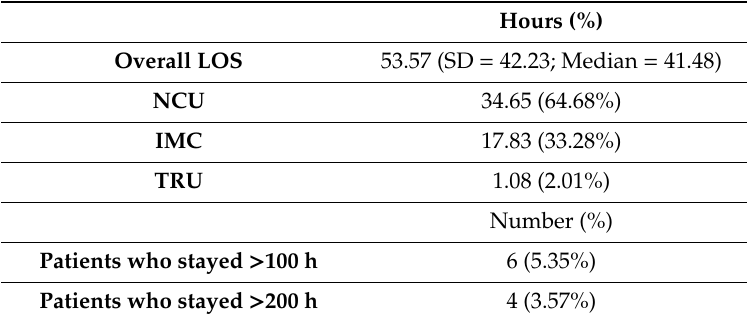
Table 9. The average length of stay